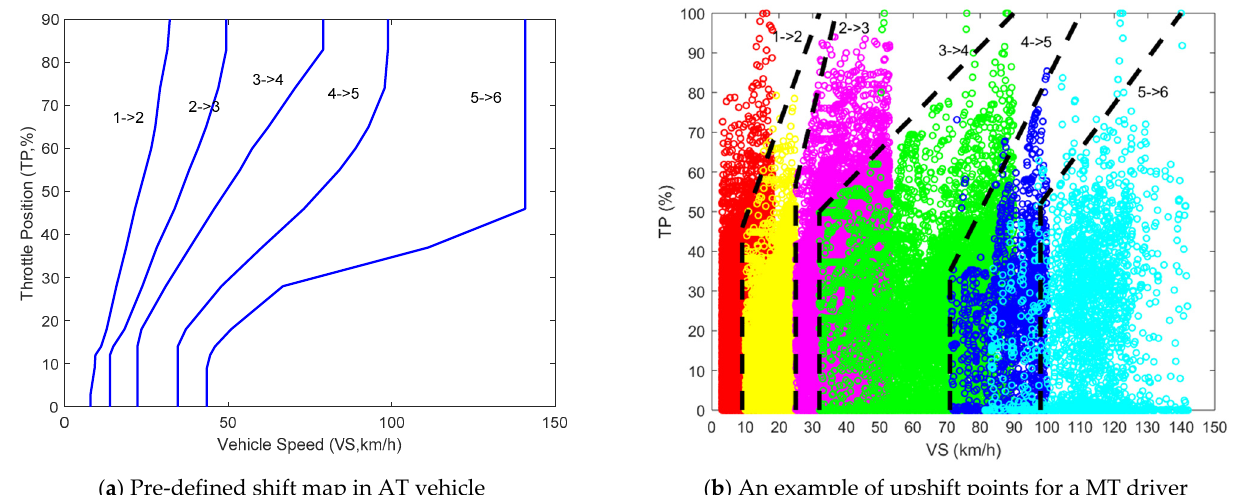
Figure 3. Descriptions of shifting schedules. ( a ) Pre-defined shift map containing different upshift curves; ( b ) Upshift points and shift curves of MT driver.